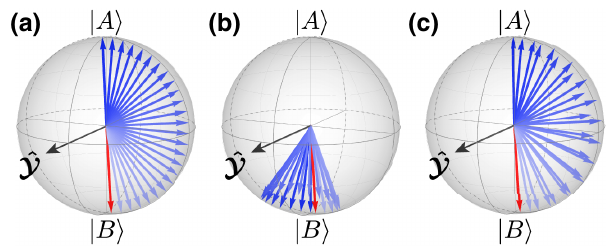
FIG. 2. Visualization of Grover’s algorithm and generalized oracle. (a) Grover’s algorithm with ideal oracle for N = 2 10 and N A = 1. Over repeated iterations (blue), the state | ψ 0 (cid:3) (red) approaches the solution state | A (cid:3) . (b) Grover’s algorithm with naive application of the generalized oracle for (cid:10) = 0.25.